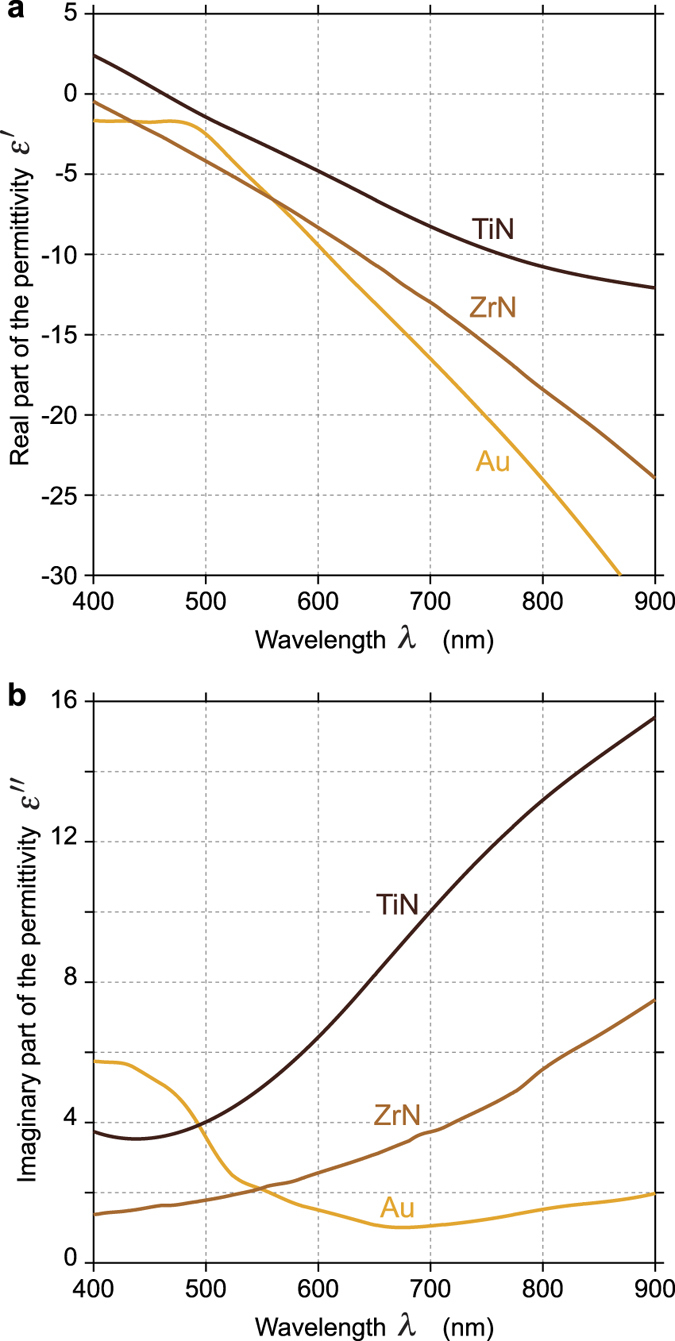
Real (a) and imaginary (b) parts of the permittivity of Au, TiN and ZrN as a function of the wavelength calculated from data sets of Johnson and Christy41 (for gold) and Palik’s Handbook42 (for metal nitrides).